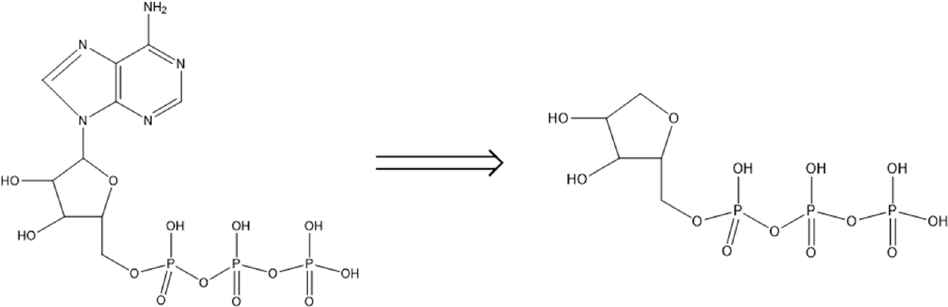
Figure 7. Proposed degradation pathway of ATP by ferrate (VI) oxidation. (P = 500 μ g/L; Fe (VI) = 5.0 mg/L; and pH =